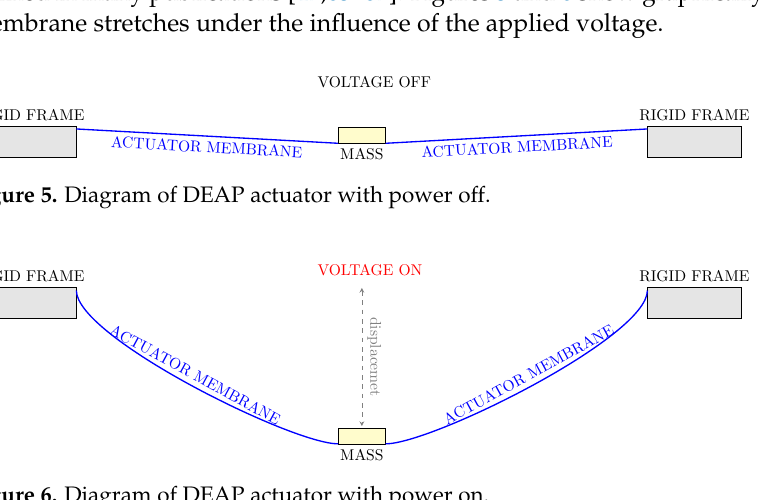
Figure 6. Diagram of DEAP actuator with power